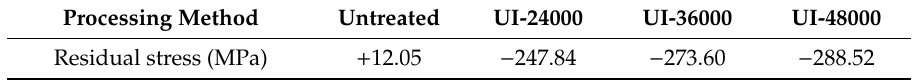
Table 3. Residual stress of TLM titanium